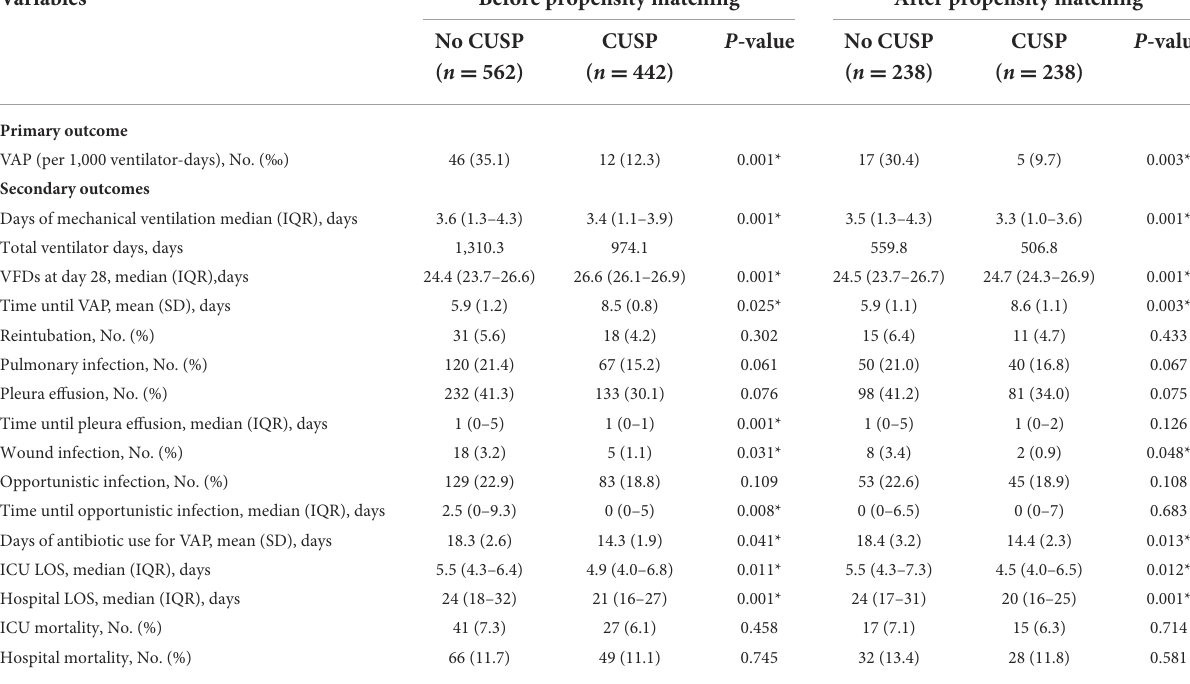
TABLE 3 Primary and secondary outcomes, based on the study group in the TICU setting. Variables Before propensity matching After propensity